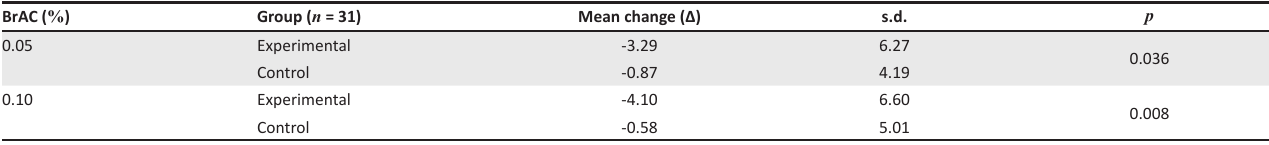
TABLE 3: Mean change for positive fusional vergence at distance for blood respiratory alcohol concentration levels of 0.05 % and 0.10 % . BrAC ( % ) Group ( n = 31) Mean change (∆) s.d. p 0.05 0.10